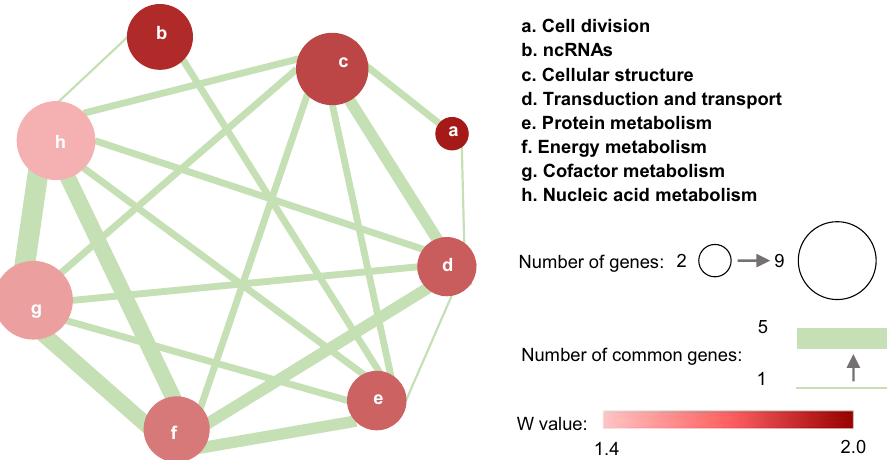
Fig. 6 Functional network plot of the bene fi cial genes derived from omics analyses. The size of the node represents the number of genes within the function set. The node color represents the W value of the function set. The thickness of the line indicates the number of genes overlapping between two function sets. The W value was calculated by averaging the maximum FFAs ratio of the engineered strains corresponding to each gene in the function set. Genes and the FFAs ratio are shown in Supplementary Data 3. Source data are provided as a Source Data fi